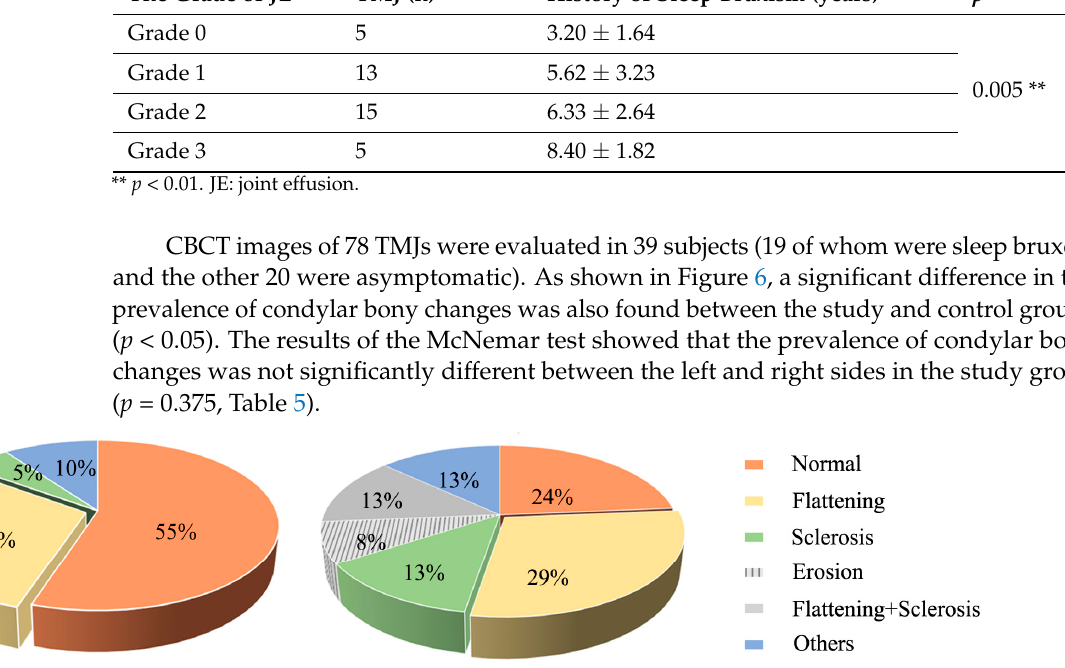
Table 4. The association between the grade of joint effusion and the history of sleep bruxism. The Grade of JE TMJ (n)